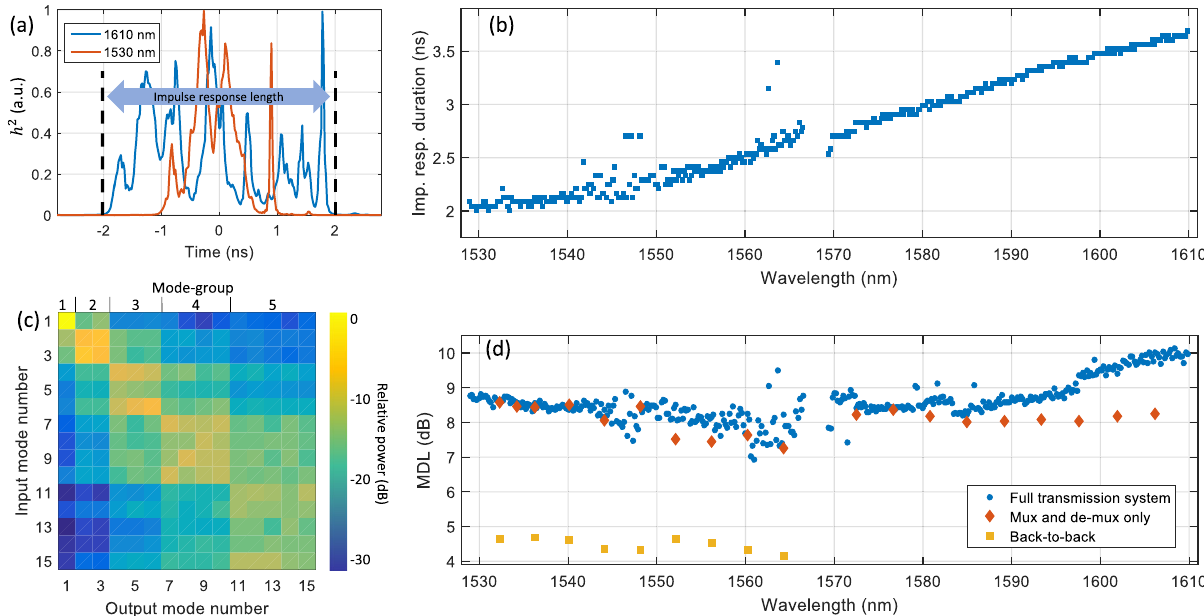
Fig. 4 Wavelength dependence of the linear transmission properties. a Intensity impulse responses of two wavelength channels. b Impulse response durations for all 382 wavelength channels. c Modal power coupling matrix for the wavelength channel at 1550 nm. d Mode-dependent loss (MDL) for all 382 wavelength channels after transmission and for selected wavelength channels in a back-to-back setup and with mode-multiplexers